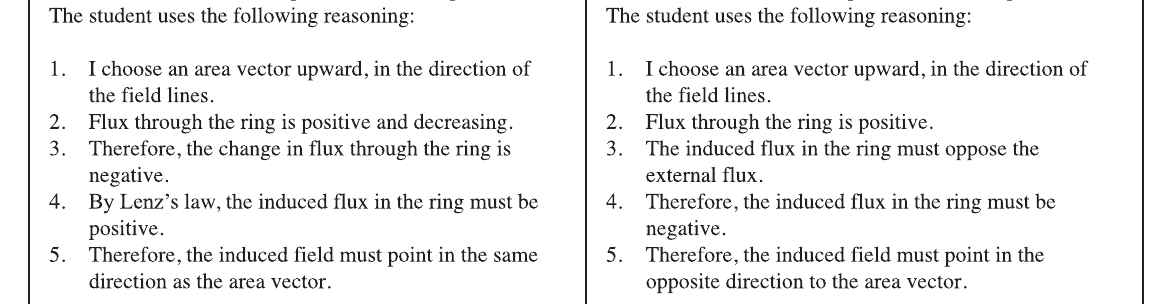
FIG. 4. Follow task 4, the magnetic induction follow task. The base task is shown in (a). The reasoning chain shown in (b) supports the correct conclusion that the induced current will flow counterclockwise in the loop. The reasoning chain shown in (c) is incorrect and suggests that the induced current will flow clockwise in the loop.